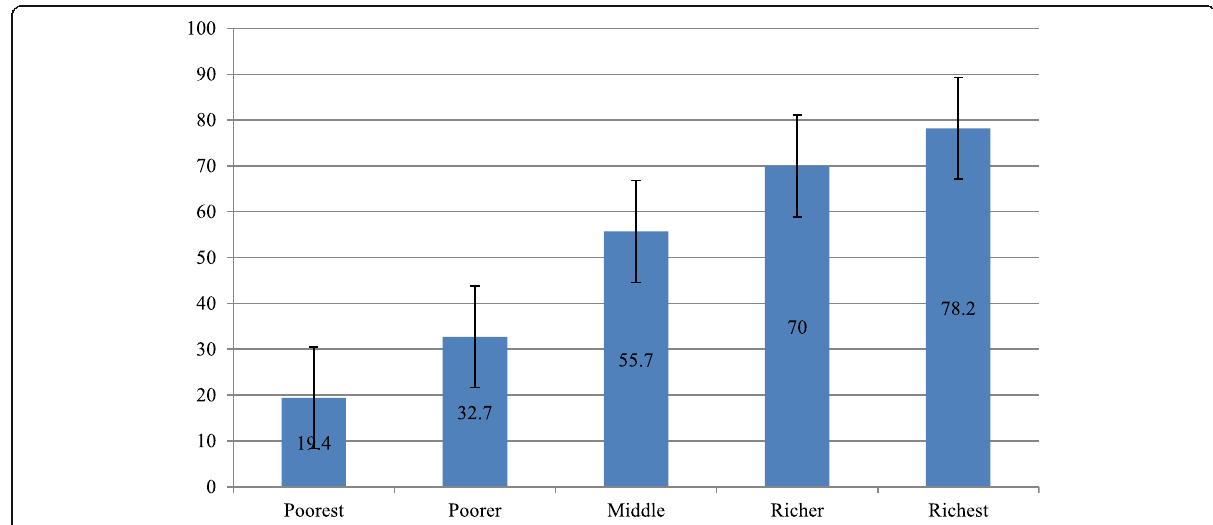
Fig. 3 Utilization of deworming medication among pregnant women based on household economic status: evidence from 26 sub-Saharan African countries